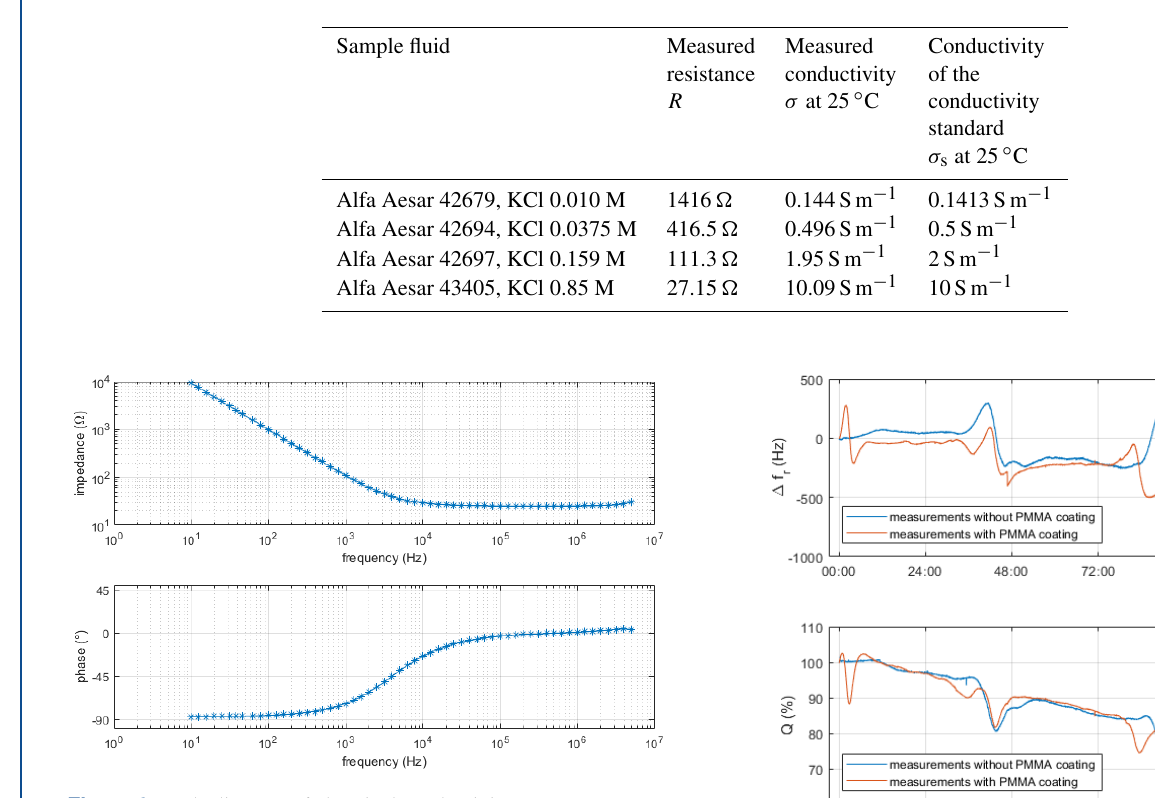
Table 1. Comparison of the measured conductivities and those given by the conductivity standards.